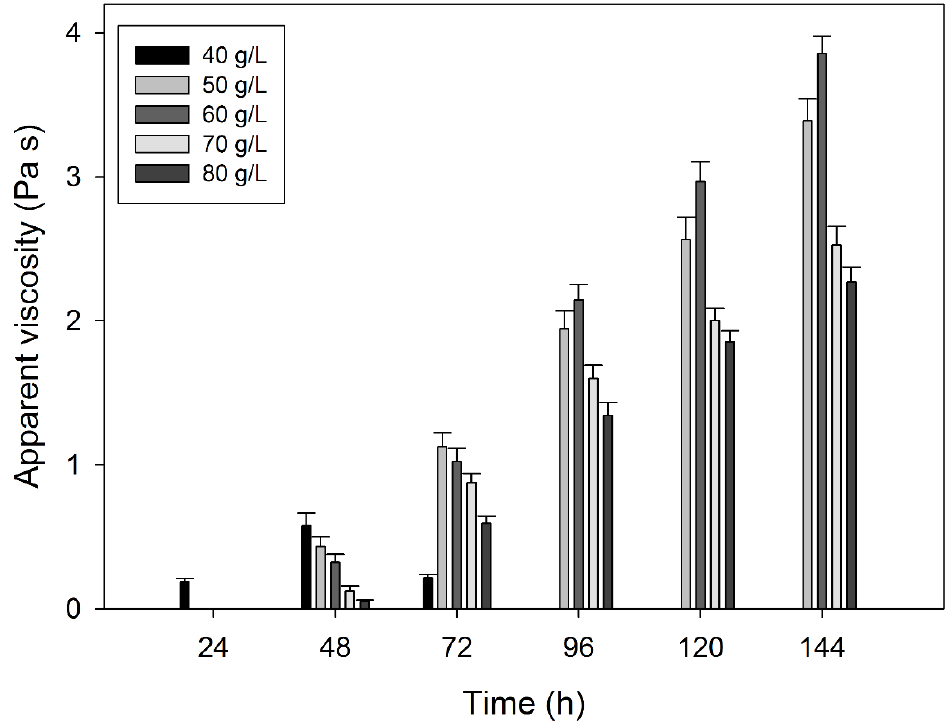
Figure 2. Apparent viscosity values (Pa s) obtained in cultures of Rhizobium viscosum CECT908 grown in synthetic medium containing different concentrations of sugarcane molasses (40–80 g/L) instead glucose. The assays were performed at 28 °C and 180 rpm. The results represent the average ± standard deviation of three independent experiments.